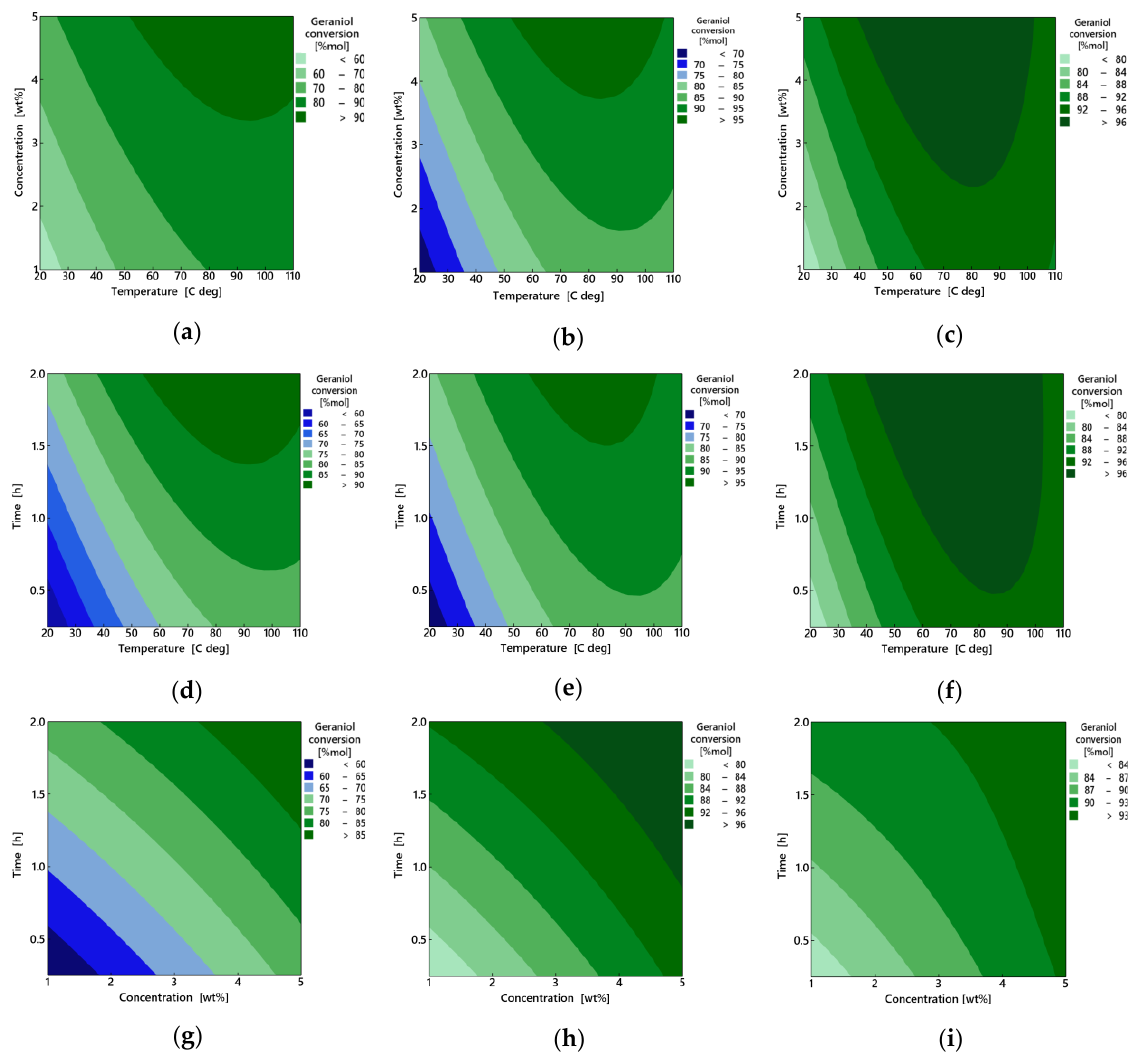
Figure 2. Contour plot of geraniol conversion at: time: ( a ) 0.25 h, ( b ) 1.125 h, and ( c ) 2 h, concentration: ( d ) 1 wt.%, ( e ) 3 wt.%, and ( f ) 5 wt.%, and temperature: ( g ) 20 °C, ( h ) 65 °C, and ( i ) 110 °C.